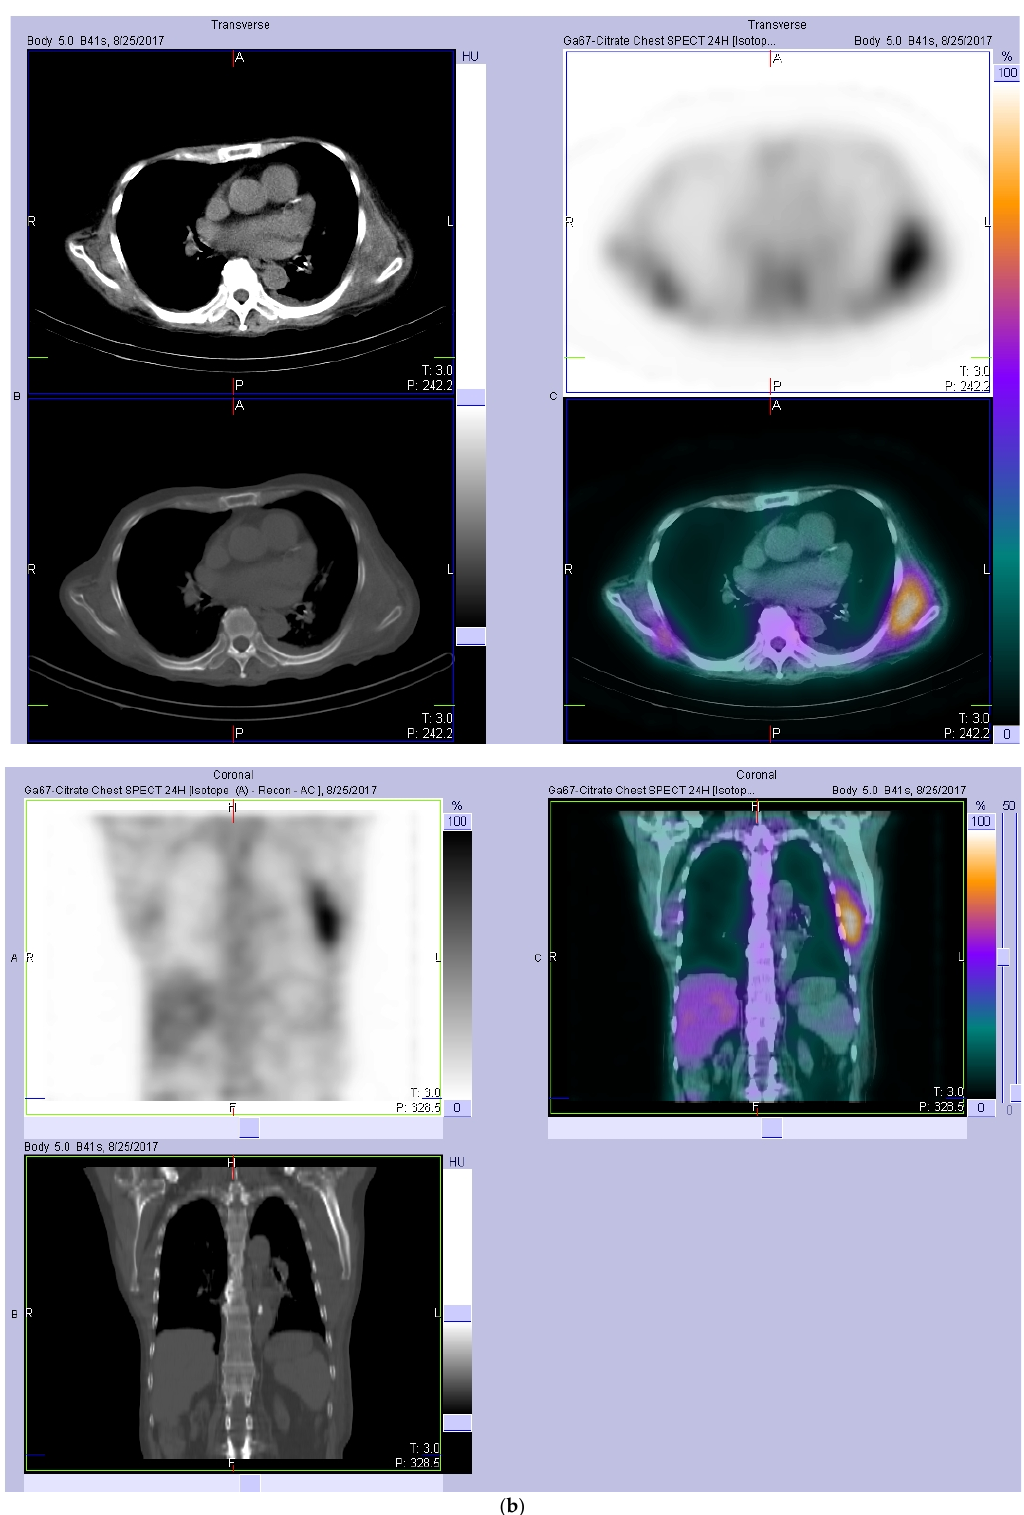
Figure 1. ( a ) CT scan of the chest. A heterogenous, relatively well-defined, soft tissue mass located along the left serratus anterior muscle, measuring approximately 5.5 × 4.2 × 2.0 cm 3 in the super- oinferior, oblique, and transverse dimensions. ( b ) The single photon emission computed tomogra- phy (SPECT/CT) images of a gallium scan. Note significantly greater gallium uptake at the poster- olateral aspect of the left chest wall. The upper one (transverse section) and lower one (coronal section) both showed increased uptake in this mass over chest wall. Fine needle aspiration and trucut biopsy of the chest wall mass showed some non- representative necrotic debris, blood and histiocytes. No definite diagnosis was obtained from the biopsy. Due to diagnostic challenges, a surgical resection of the mass was carried out with an open excision. Overall, the specimen had a rubbery and tan appearance and was 5.5 × 4.2 × 2.0 cm 3 in size. Histologic examination of the specimen was consistent with amyloidoma, with Congo red stain confirming amyloid deposits and apple-green bire- fringence under polarized light. The diagnosis was compatible with a β -2-microglobulin related amyloid deposition. The patient had no postoperative complications. He did not have any fever during the week prior to discharge. The patient remained in a stable condition, with no evidence of recurrence. 3. Discussion Tumor-like localized amyloid deposits (amyloidoma) are uncommon. They appear in the gastrointestinal tract, bladder, lung, head and neck region and soft tissues. Until now, only seven instances of such amyloidoma on the chest wall have been reported [1– 7]. The differential diagnosis includes a primary tumor, metastatic disease or infectious